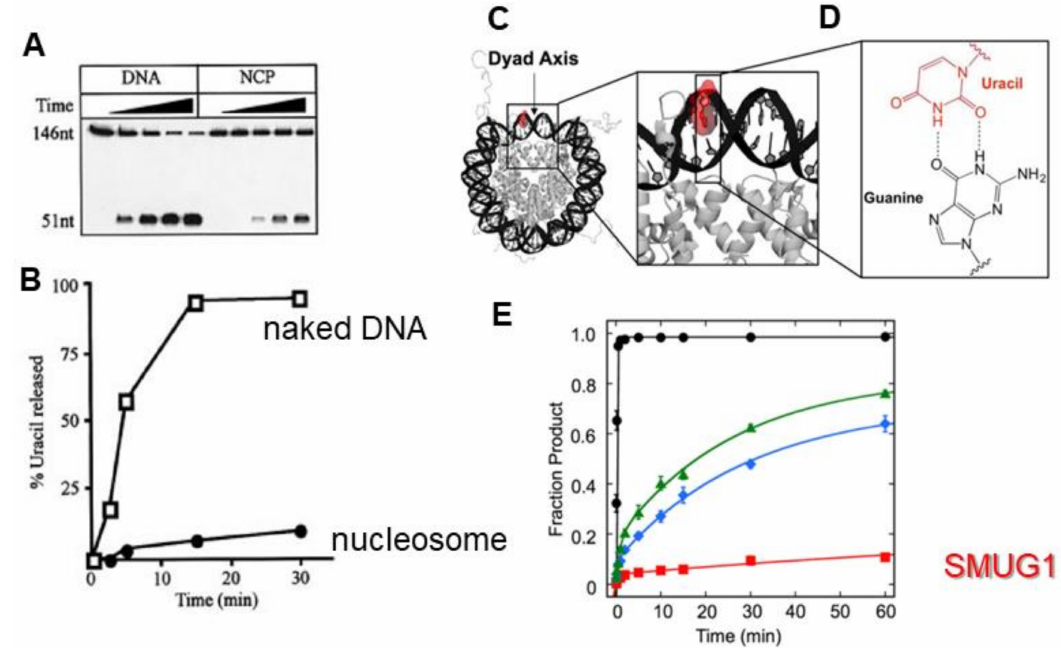
Figure 3. SMUG1 processes lesions within nucleosomes inefficiently. SMUG1 ( A ) excision activity and ( B ) kinetics on naked DNA and nucleosome core particle (NCP), from [14] with permissions. ( C ) Crystal structure of the NCP highlighting the ( D ) U:G wobble base pair lesion from [15] with permission. ( E ) SMUG1 excision kinetics (red) compared to the activity of other UDG glycosylases, UNG (black) TDG (blue, green) from [15] with